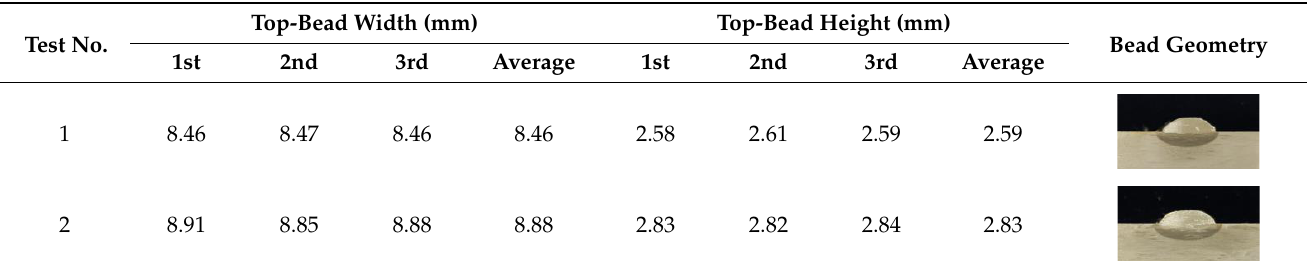
Table 4. Results of weldment geometry through welding experiment.